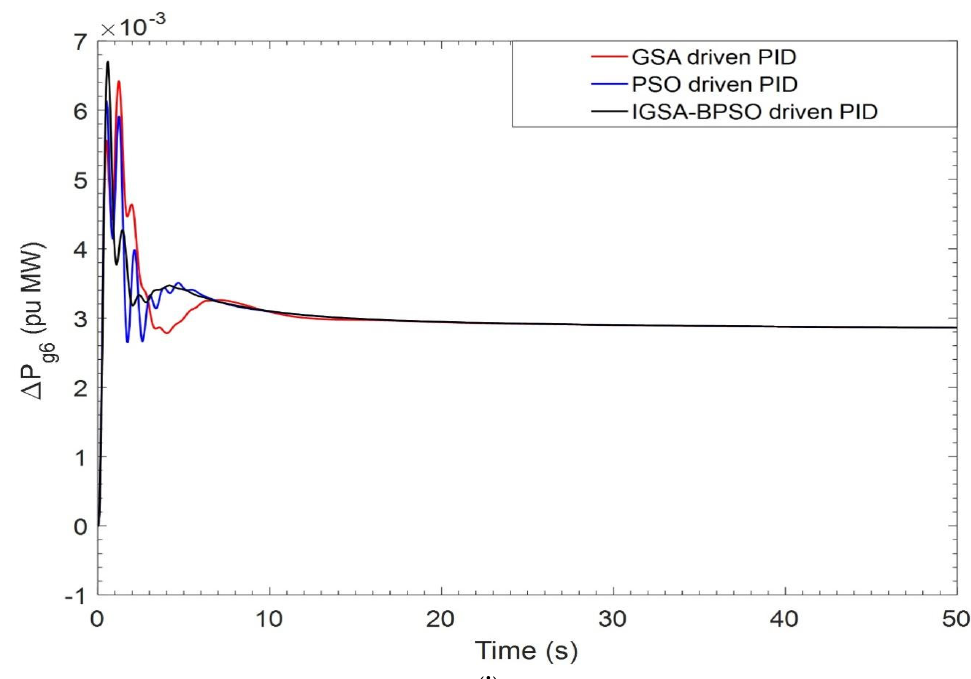
Figure 6. ( a ) Dynamic response of Δ F 1 for BBT case; ( b ) dynamic response of Δ F 2 for BBT case; ( c ) dynamic response of Δ P tie for BBT case; ( d ) perturbation response of GENCO–1 for BBT case; ( e ) perturbation response of GENCO–2 for BBT case; ( f ) perturbation response of GENCO–3 for BBT case; ( g ) perturbation response of GENCO-4 for BBT case; ( h ) perturbation response of GENCO-5 for BBT case; ( i ) perturbation response of GENCO-6 for BBT case.